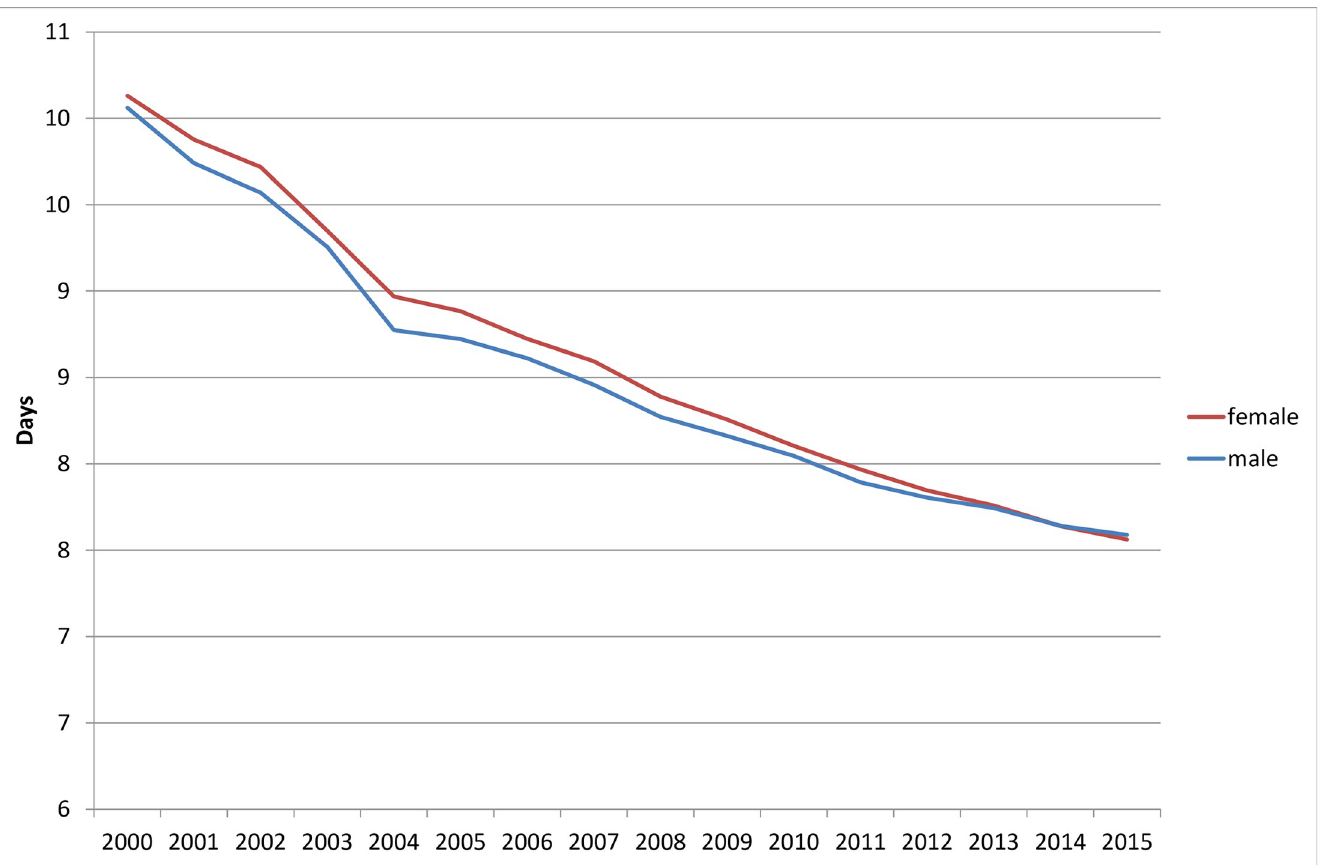
Fig 1. Average length of stay in hospitals (day per case), 2000 to 2015. Source: Hospital statistics 2000–2015 [19].